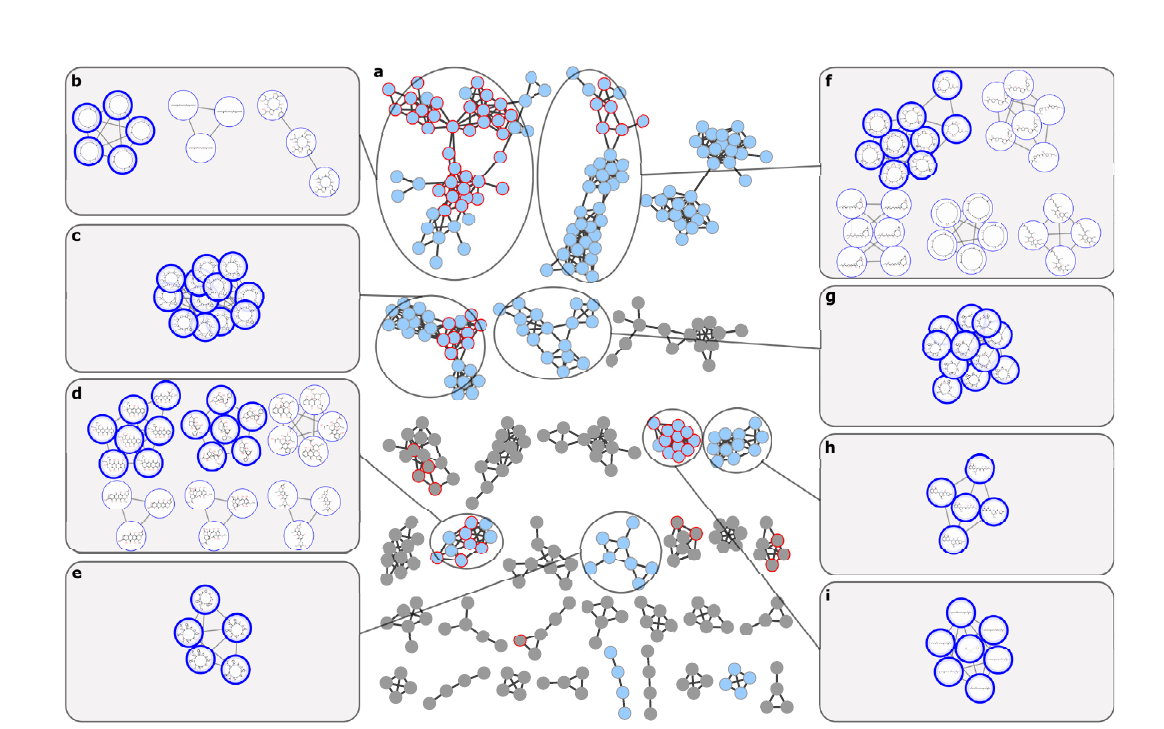
Fig. 5 | Bacterial molecular network with SNAP-MS annotations. a Molecular networkfor925marinebacteriaprefractions, fi lteredtoremovesolventandmedia blanks and subnetworks with fewer than four nodes. Nodes annotated by GNPS spectral libraries are outlined in red. Subnetworks annotated by SNAP-MS are